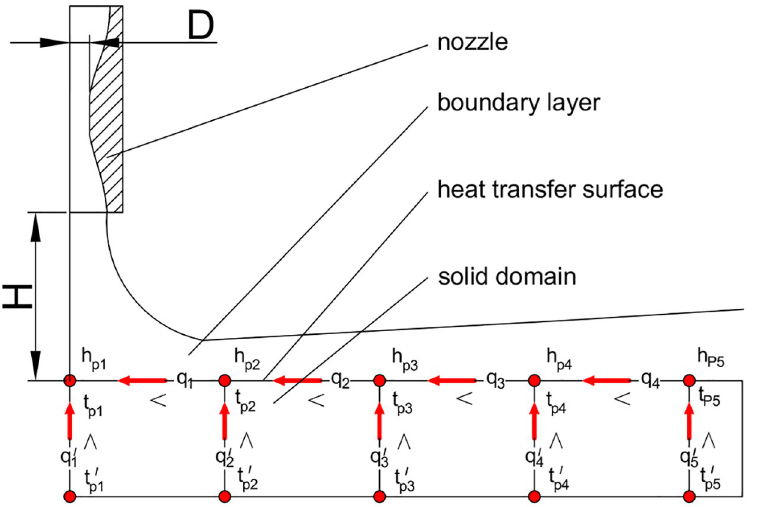
Fig 1. Heat transfer network analysis of the conjugate heat transfer